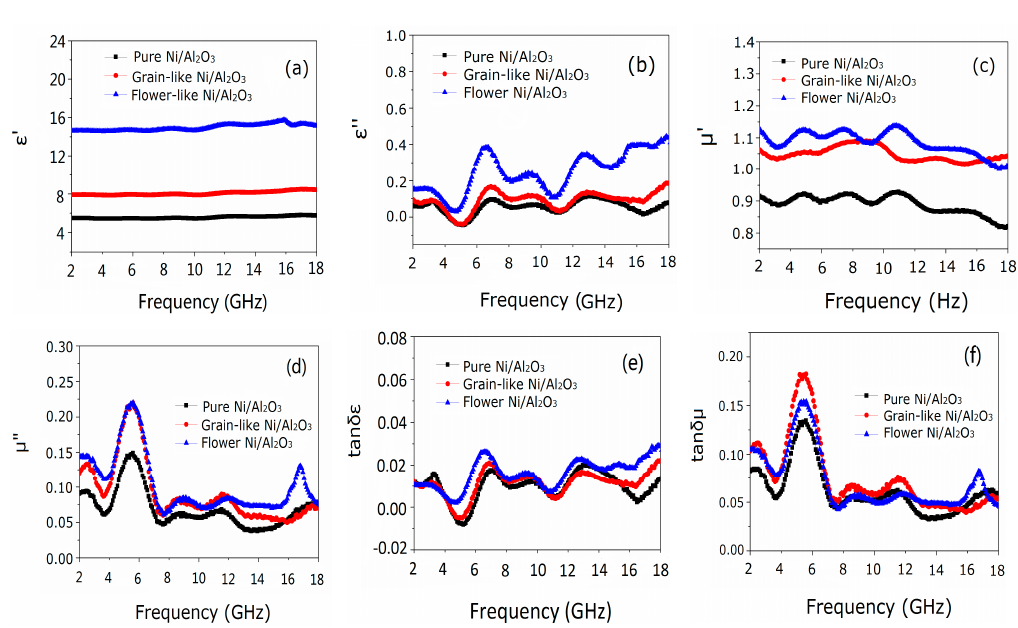
Figure 7. Electromagnetic parameters of three Ni / Al 2 O 3 / Ni samples: real ( a ), imaginary ( b ) part of the complex permittivity; real ( c ), imaginary ( d ) part of the complex permeability and tangent dielectric loss ( e ) and tangent magnetic loss ( f ) in the frequency range of 2–18 GHz.